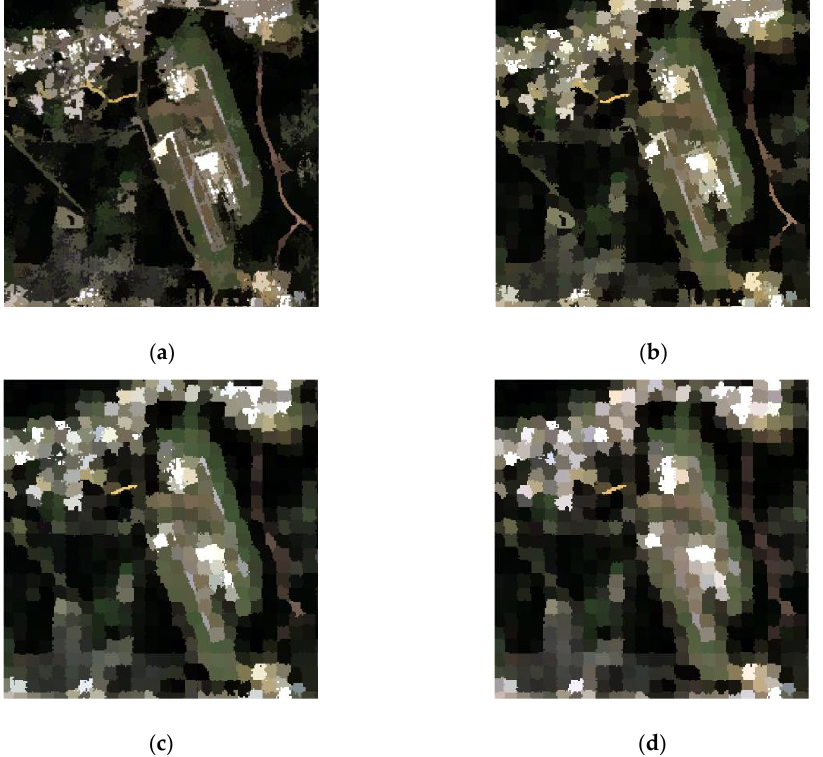
Figure 8. Results of different compactness parameters for Landsat satellite imagery: ( a ) m = 10; ( b ) m = 20; ( c ) m = 30; ( d ) m = 40.